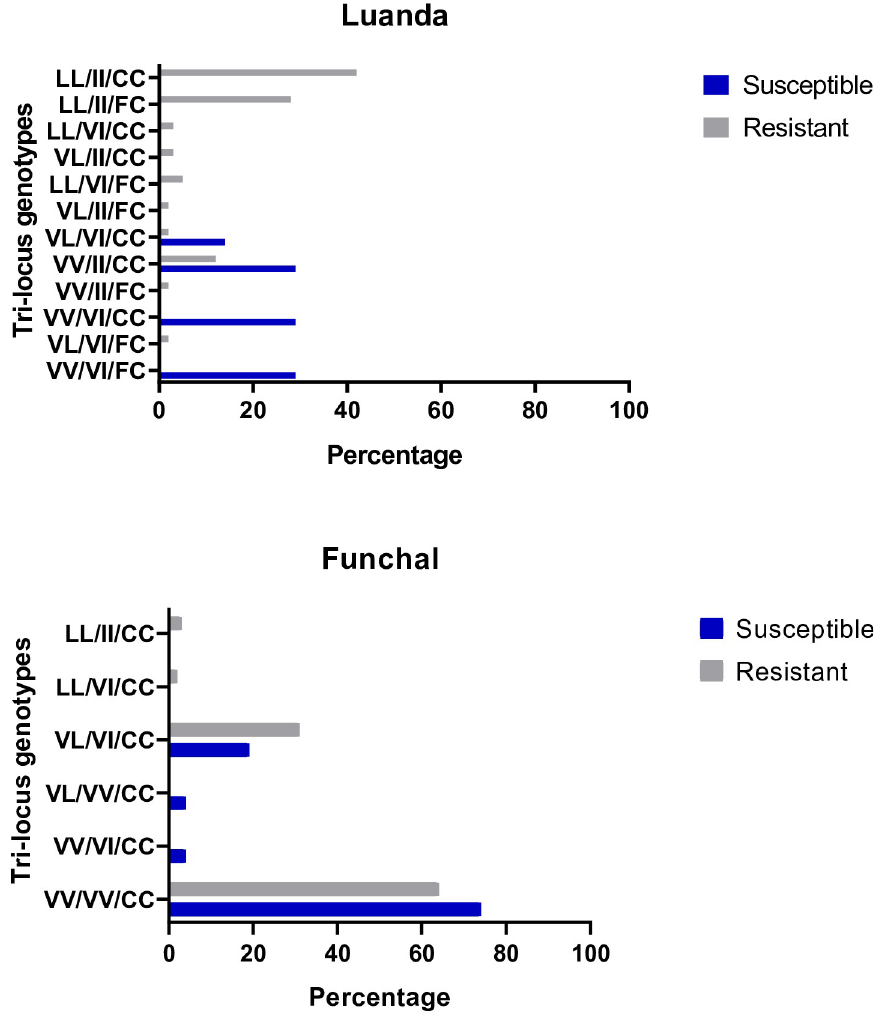
Fig 3. Frequencies of tri-loci genotypes in phenotyped mosquitoes from Luanda and Madeira. Each tri-locus genotyped is named according to the genotypic composition at each kdr mutation following the order 410 (VV, VL or LL) / 1016 (VV, VI or II) / 1534 (FF, FC or CC).